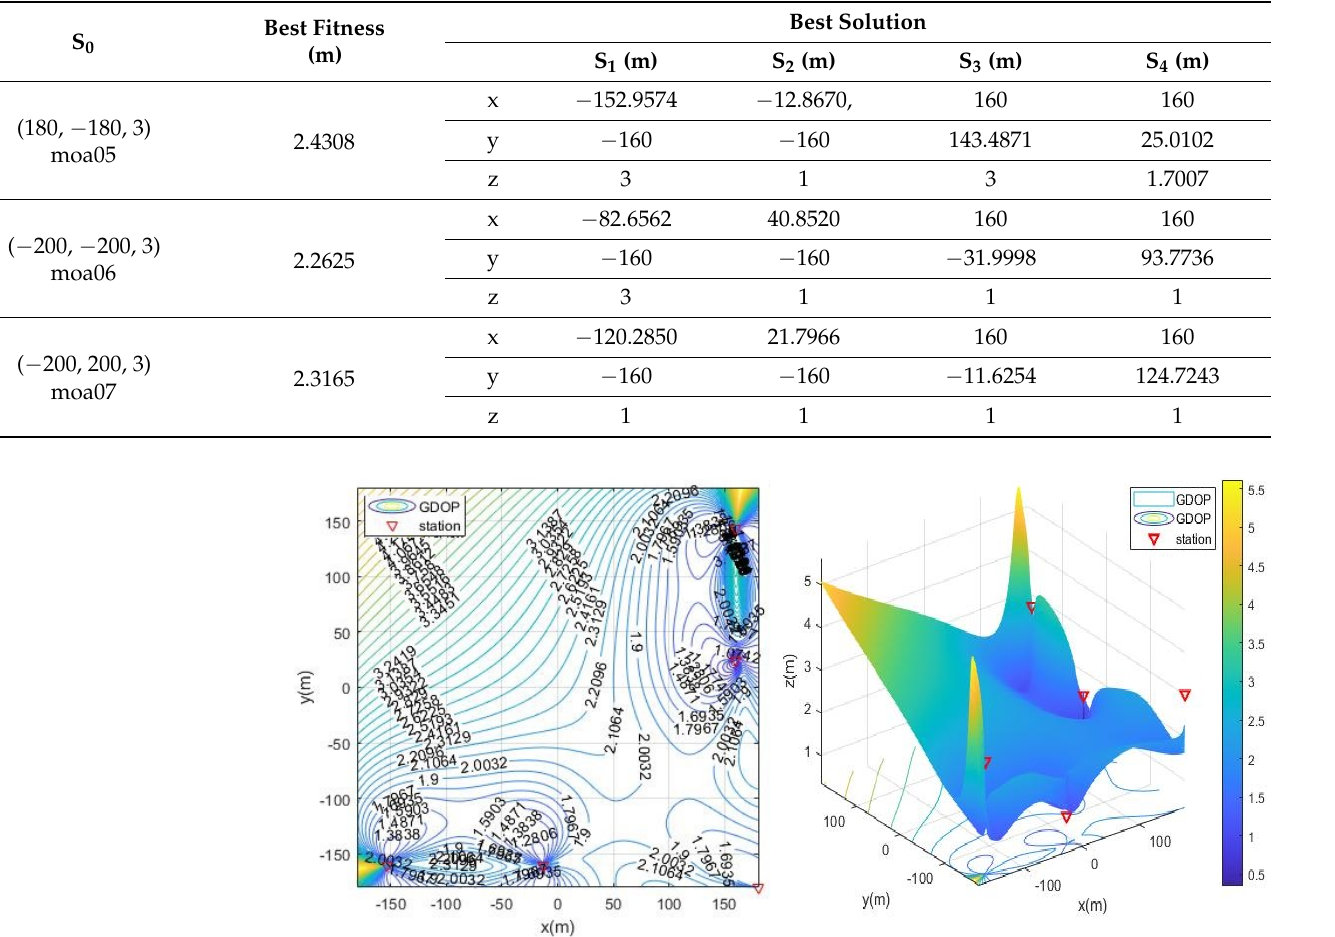
Table 3. Optimized results of the five station deployments.